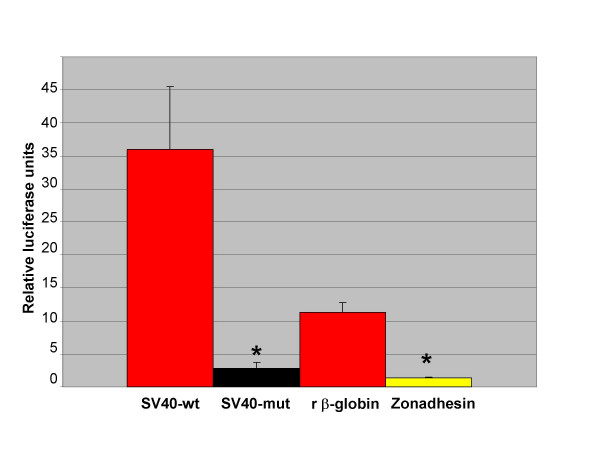
The luciferase assay evaluates polyadenylation efficiency. ATCC 3T3 cells (mouse embryonic fibroblasts) were transfected with Renilla luciferase reporter plasmids containing one of the indicated (bottom) polyadenylation cassettes as well as a firefly luciferase expressing vector to control for transfection efficiency. Two days later, extracts of these cells were assayed for luciferase activity. Indicated on the left is the relative luciferase activity (Renilla luciferase values divided by firefly luciferase values). Asterisks indicate significant difference from the SV40 wild type as determined by Student's T-test (p < 0.01).